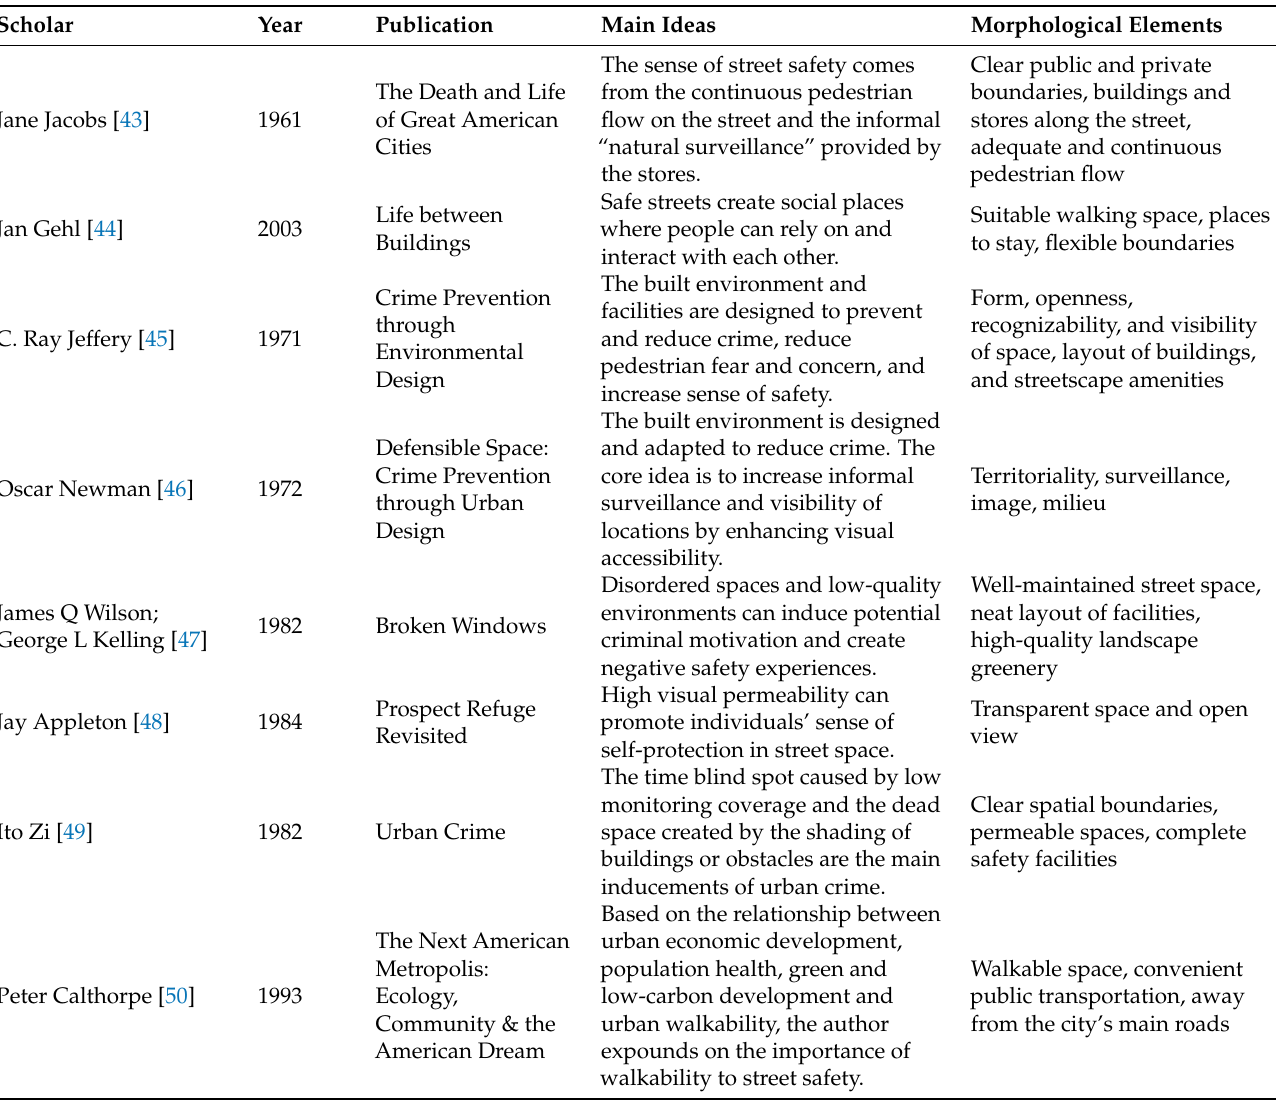
Table 1. Theories of street